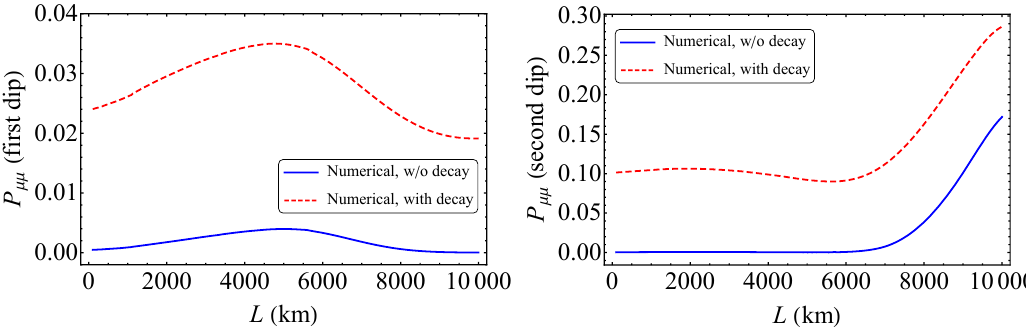
Figure 6 . The survival probabilities P µµ at the first (left) and the second (right) oscillation dips for a range of baselines L . We have taken θ decay are non-zero primarily due to Earth matter